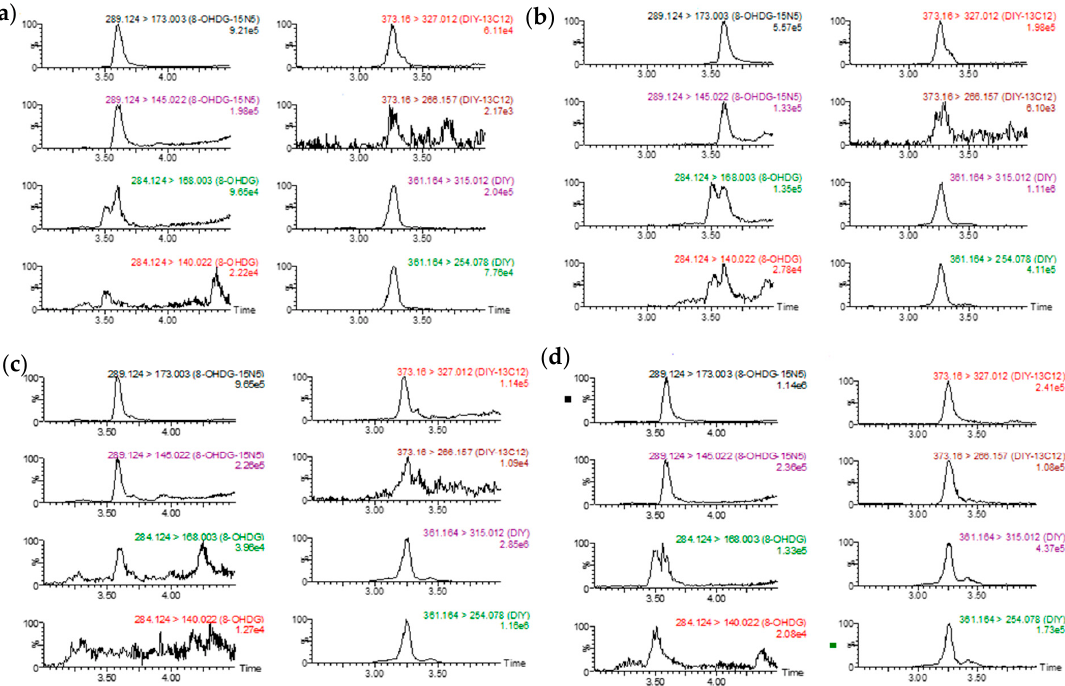
Figure 3. SRM chromatograms of TAs and ISs from randomly selected skin ( a ), gill ( b ), liver ( c ), and dorsal fin ( d ) samples. Table 2. Calibration curves, limits of detection (LODs) and quantification (LOQs), and precision for the determination of 8OHDG and DIY.